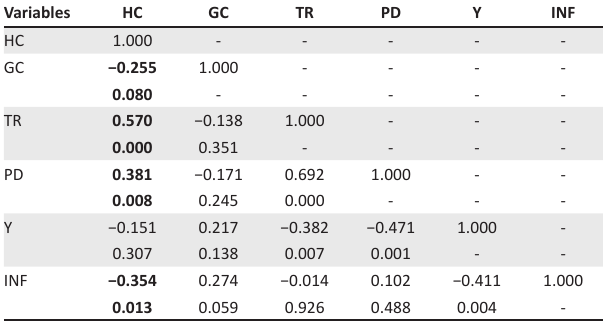
TABLE 2: Correlation matrix results: Household consumption and independent